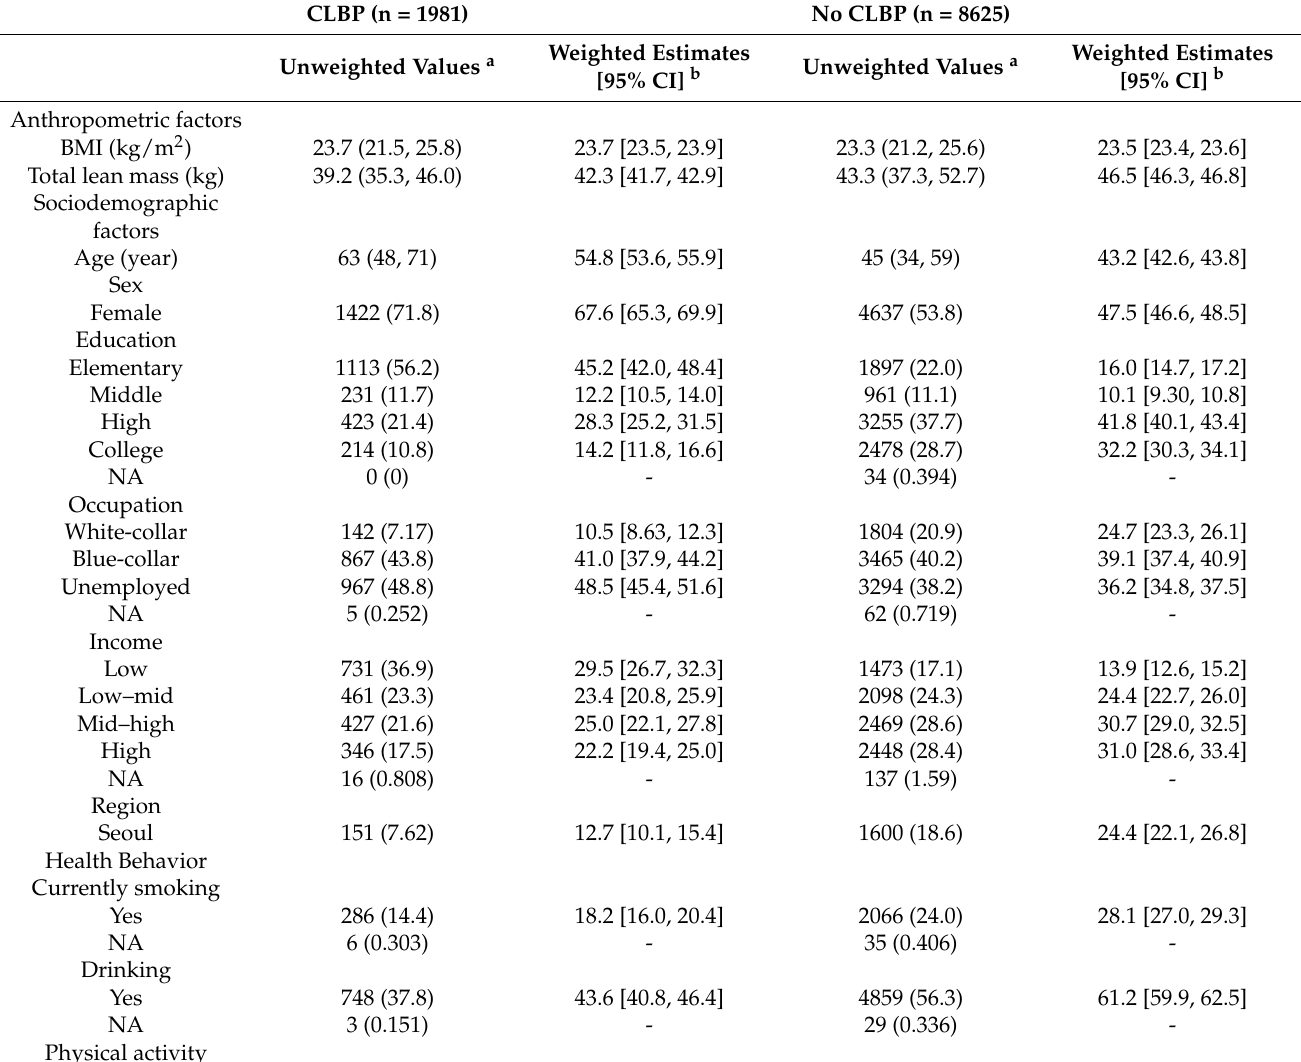
Table 1. Characteristics of the Study Population According to CLBP Status (KNHANES IV, 2008–2009). CLBP (n =